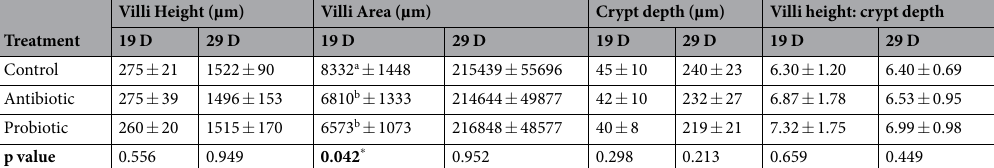
Table 3. Mean ( ± standard deviation) villi height, villi area, crypt depth and villus height: crypt depth ratio of the duodenum of broilers slaughtered on day 29. * p < 0.05, a, b Means within columns with different superscripts differ significantly (p <